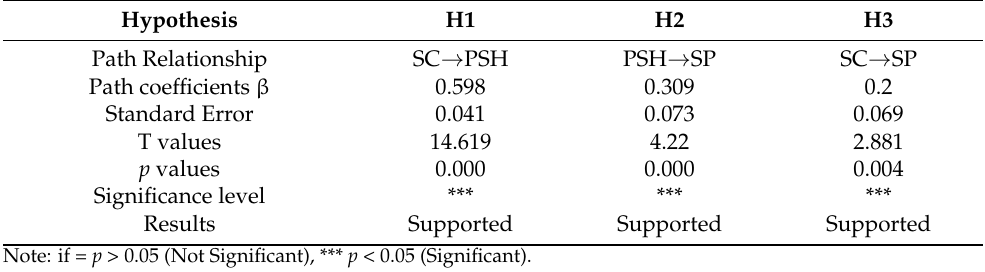
Table 7. Direct Effect Results.